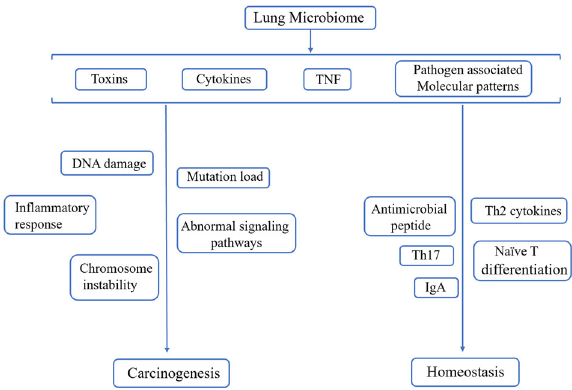
Fig. 2 Lung microbiome play a dual role in promoting carcino- genesis and maintaining homeostasis in different conditions. Lung microbiome can induce carcinogenesis via causing DNA damage, in fl ammatory response alterations, chromosome instability, abnormal signaling pathway activations and increasing mutation load through productions of bacterial toxins and multiple cytokines. On the other side, the process of colonization and maturation lung- resident microbiome community also participates in the maturation of lung and promoting host homeostasis and tolerance, as well as conferring susceptibility to lung disorders during exposure to complex external